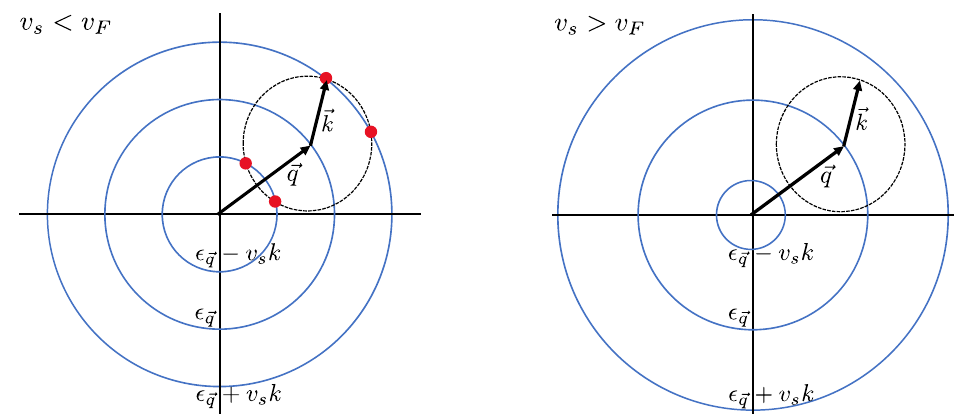
Figure 6: An electron with momentum (cid:126) q absorbing or emitting a phonon with mo- (cid:126) (cid:126) ± v k acquires final momentum (cid:126) q ± k and energy ε (cid:126) k . These two conditions mentum q s < v can be satisfied only if v , as in the left figure, where the four red dots repre- s F sent the possible final momenta. The blue circles are constant energy contours for > v the electron. If v the contours are spaced further apart relative to the phonon s F momentum and no final momenta satisfy momentum and energy conservation, as in the right